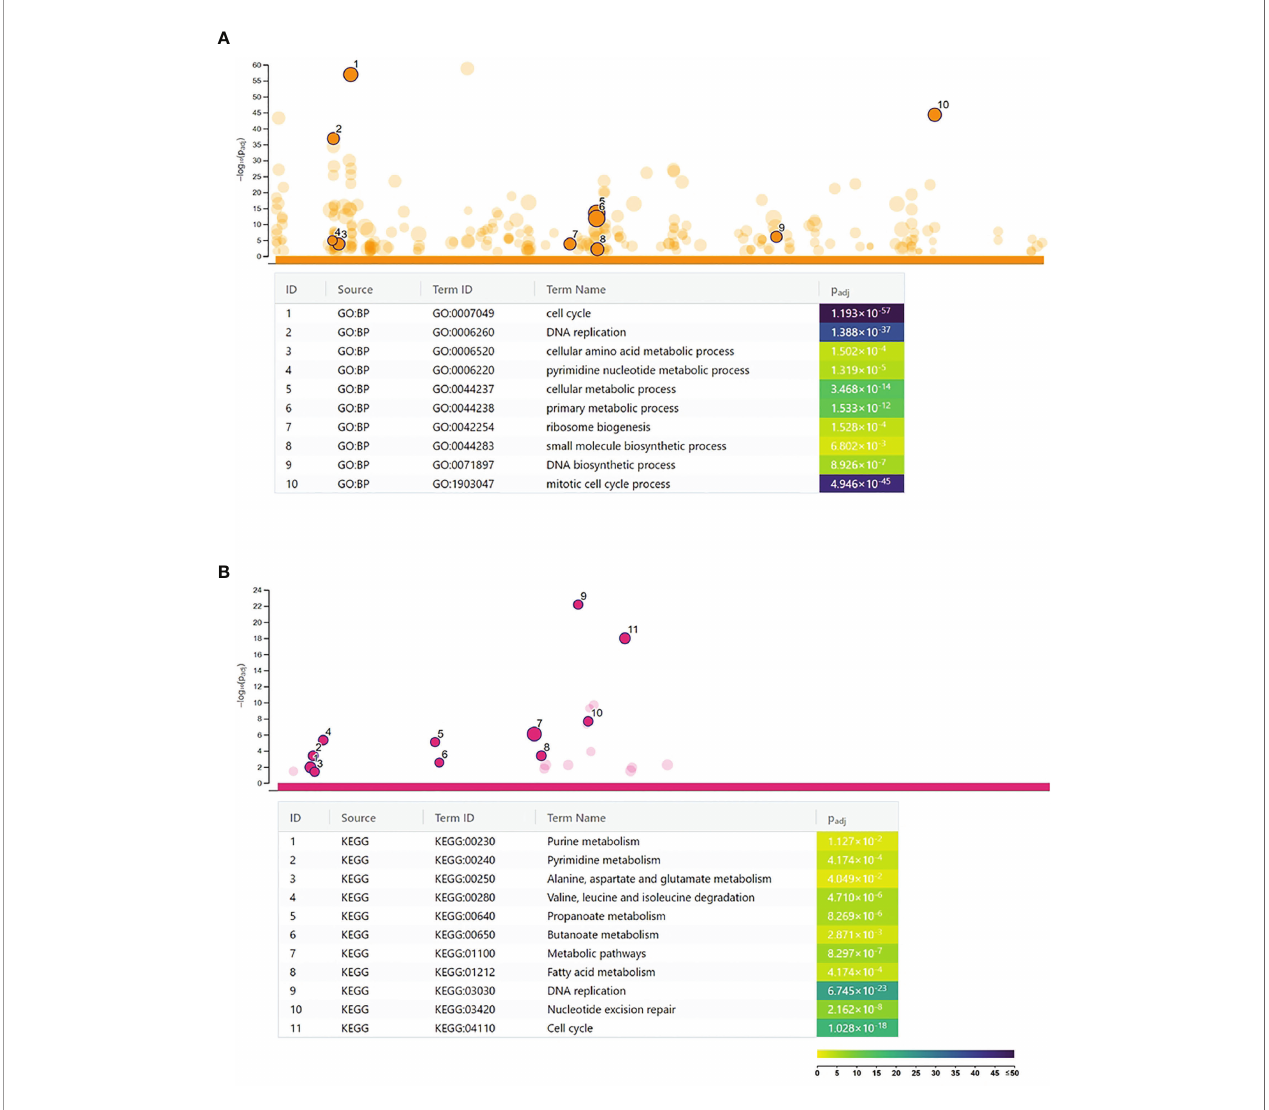
FIGURE 2 | Functionalanalysisofthe Chlamydia trachomatis infection repressedgenes. (A) Gene Ontology analysisof signi fi cantly enriched biologicalfunction terms containing repressedgenes. The names and signi fi cance levels of enrichment of selected functional category termsare shown. (B) Analysis of signi fi cantlyenrichedKyoto Encyclopedia of Genes andGenomes pathways containing repressedgenes. The names and signi fi cance levels of enrichment of selected pathwaysare shown. The color codingofbiological function and pathway termenrichment P -values denotes the signi fi cance level of enrichment. The color scaleshows the – log 10 P -value of